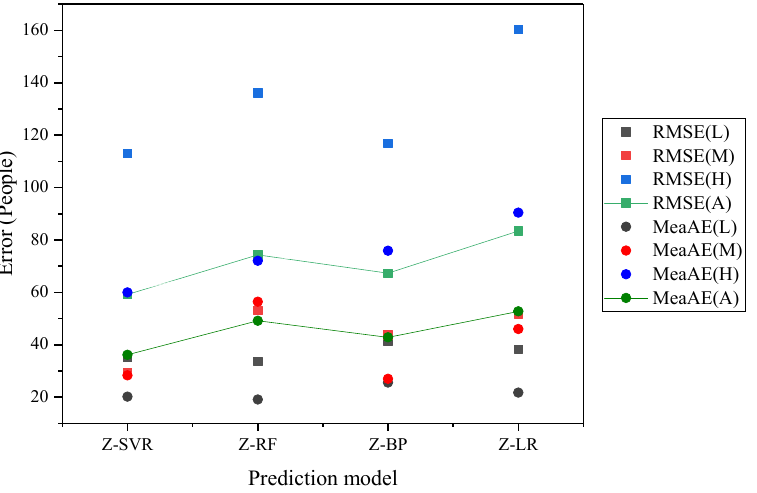
Figure 14. Model performance evaluated by the cross-validation method.